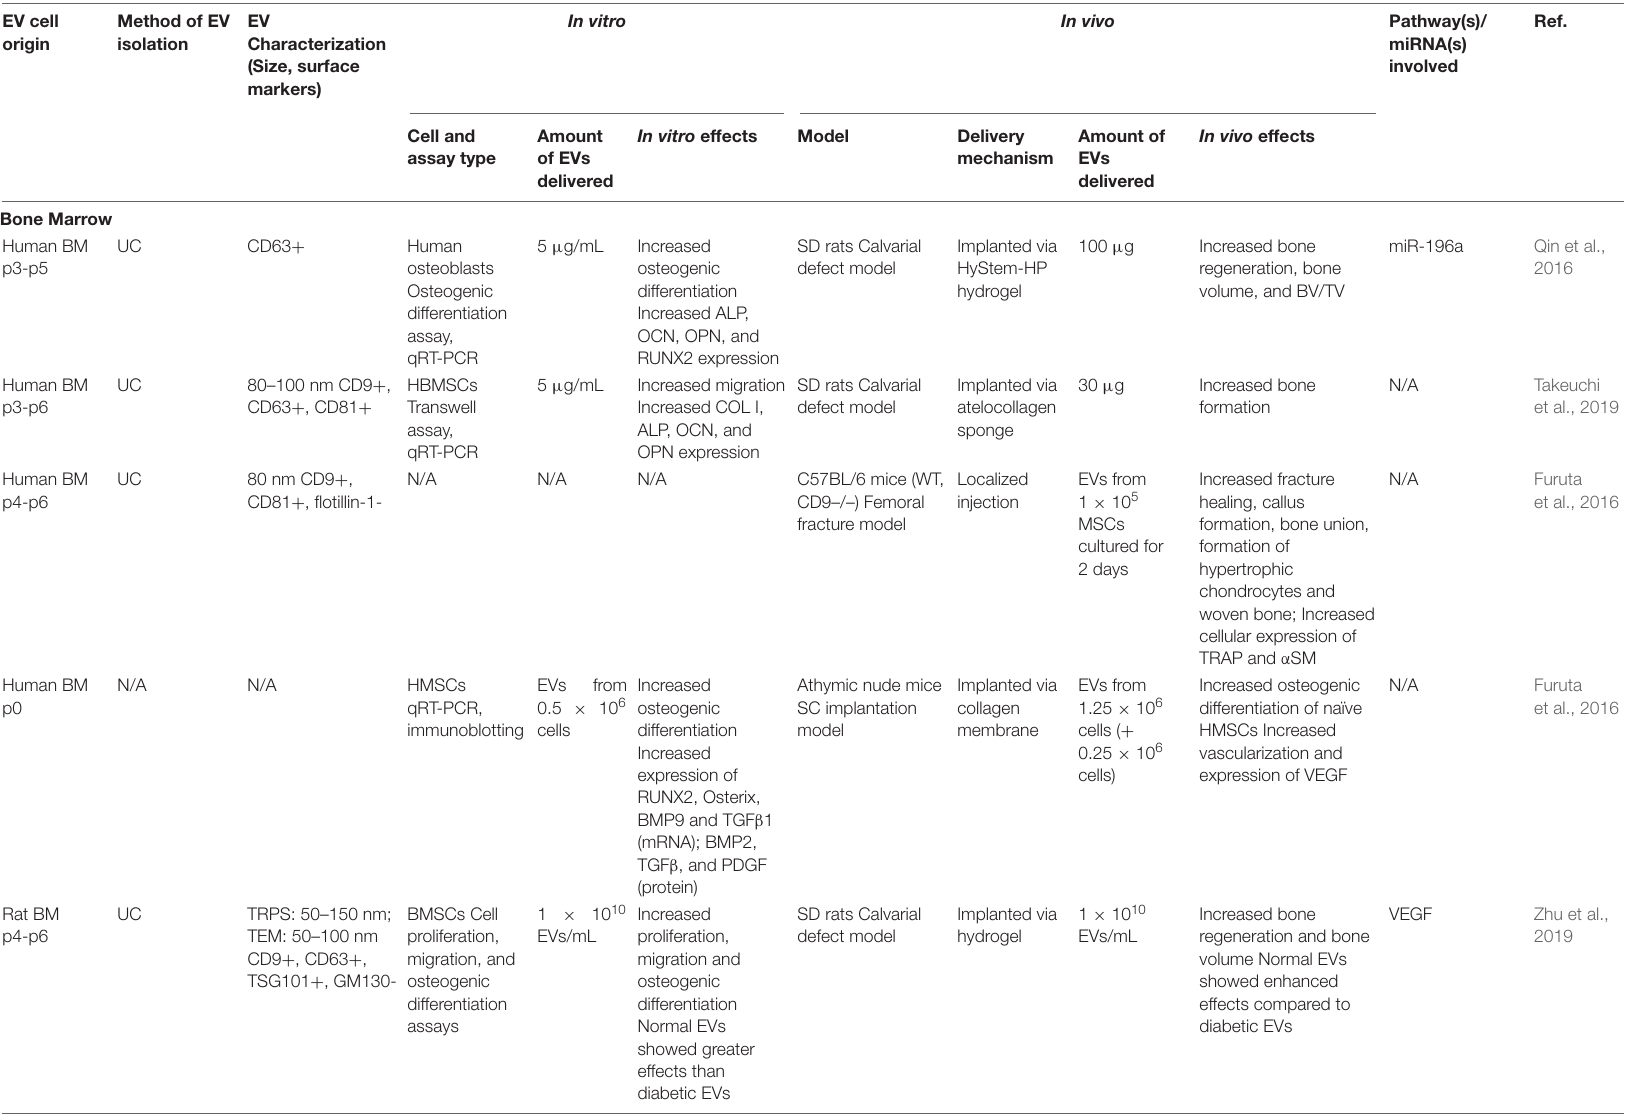
TABLE 2 | Preclinical studies employing BMMSC- and ADMSC-derived EVs to induce